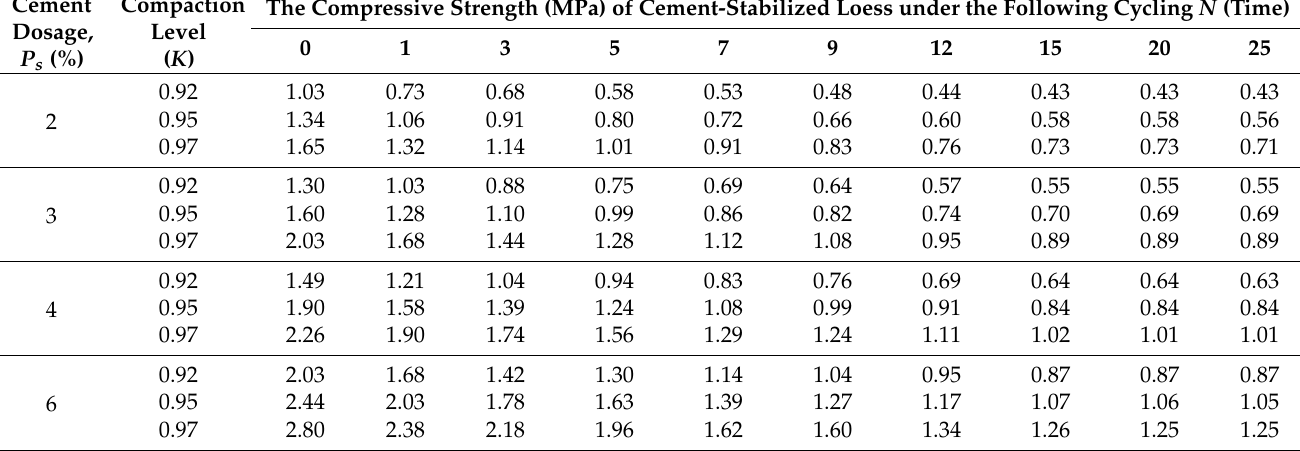
Table 6. The 28-day compressive strength test results of cement-stabilized loess under wet–dry